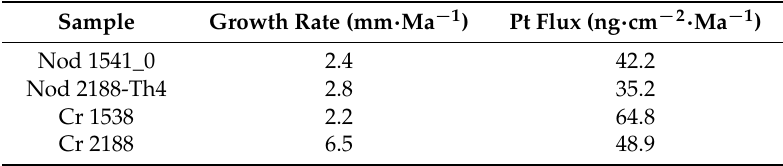
Table 5. Growth rates and Pt fluxes in investigated crust and